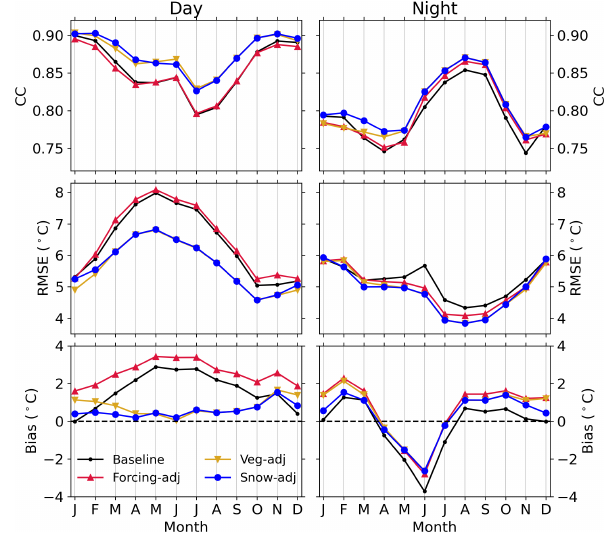
Figure 8. Time series of multiyear monthly average CC, RMSE, and bias between VIC and MODIS daily LST fields for the baseline simulation and each adjustment